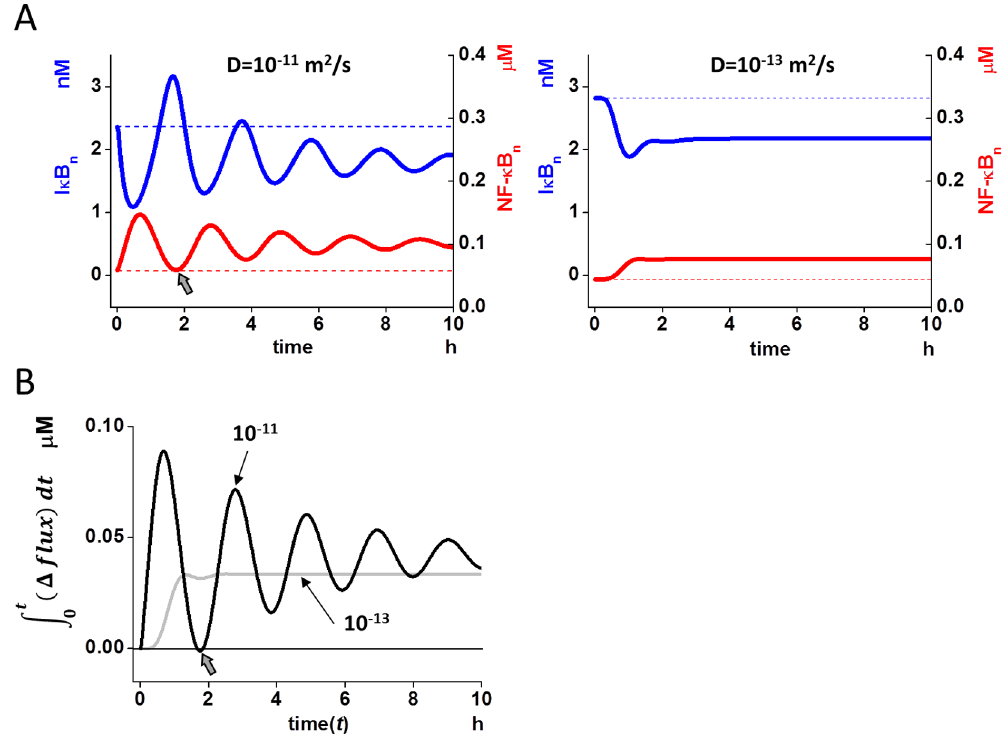
Figure 3. ‘‘Reset’’ of nuclear NF- k B by newly synthesized I k B is essential for the oscillation of nuclear NF- k B. (A) There was a difference in the nuclear I k B (I k B n ) in oscillating (left) and non-oscillating (right) conditions of diffusion coefficient (10 2 11 and 10 2 13 m 2 /s, respectively). In the oscillating condition, peak I k B n was higher than at the resting level (continuous and broken blue lines in the left panel), and NF- k B n returned to the initial level, indicating the occurrence of a ‘‘reset’’ (gray arrow). In contrast, it was lower than the resting level in the non-oscillating condition (right panel). Red lines show free NF- k B n for reference. (B) In oscillating D (10 2 11 m 2 /s, black line), cumulative D flux ( Ð t ( D flux ) dt ), which is the integral of the 0 difference in the inward fluxes of NF- k B and I k B to the nucleus from the start of the oscillation to time t , indicates a ‘‘reset’’ of the free NF- k B n level to the initial state, because the cumulative D flux reaches zero (gray arrow). Zero cumulative D flux indicates the balance of inward fluxes between NF- k B and I k B, and all NF- k B that flowed into the nucleus is transported out of the nucleus at the time of zero cumulative D flux . In contrast, the cumulative D flux does not reach zero at non-oscillating D (10 -13 m 2 /s, gray line), indicating the accumulation of NF- k B in the nucleus, and NF- k B n is not reset.